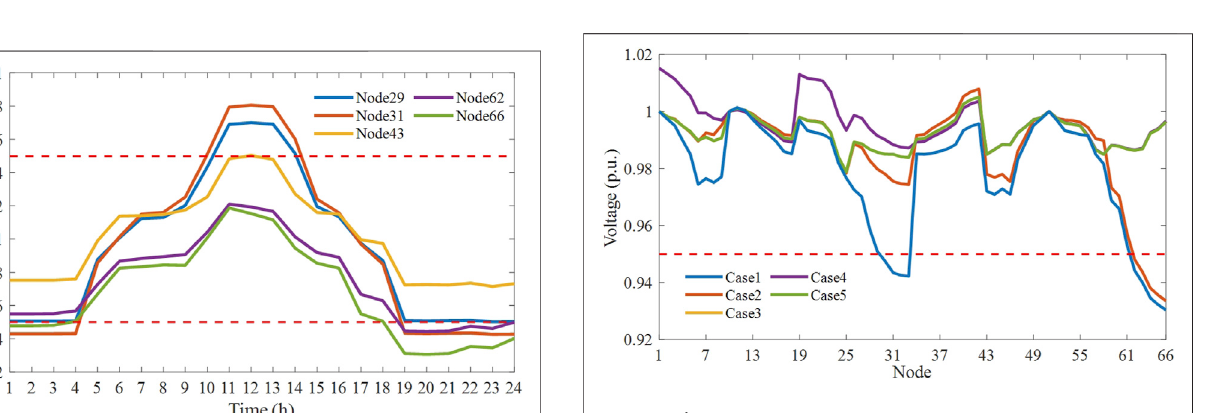
FIGURE 7 | Voltage pro fi les in different cases at